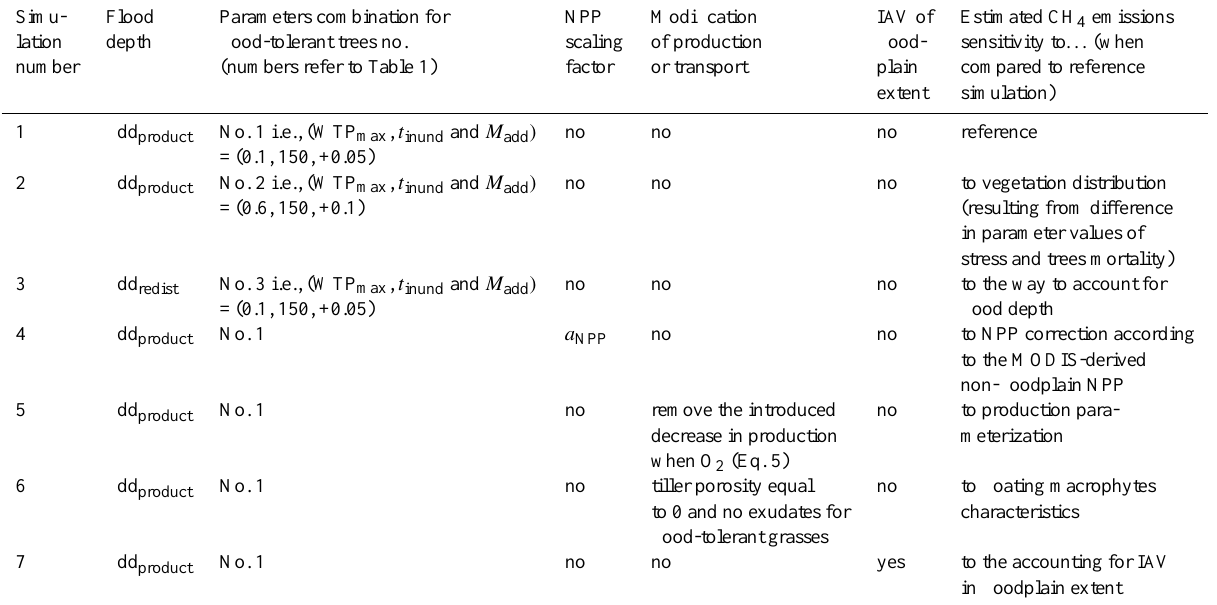
Table 5. Set-up for simulations at Amazon Basin